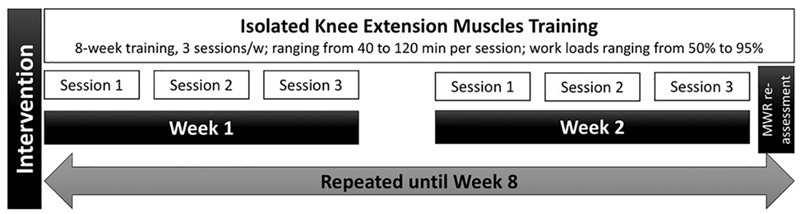
Schematic chart of the experimental design for isolated knee extension muscles training.